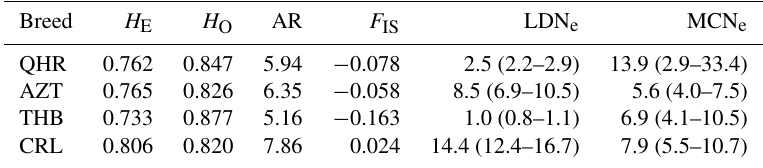
Table 2. Genetic diversity parameters and effective population size of four horse breeds in South-Central Mexico. Breed H E H O AR F